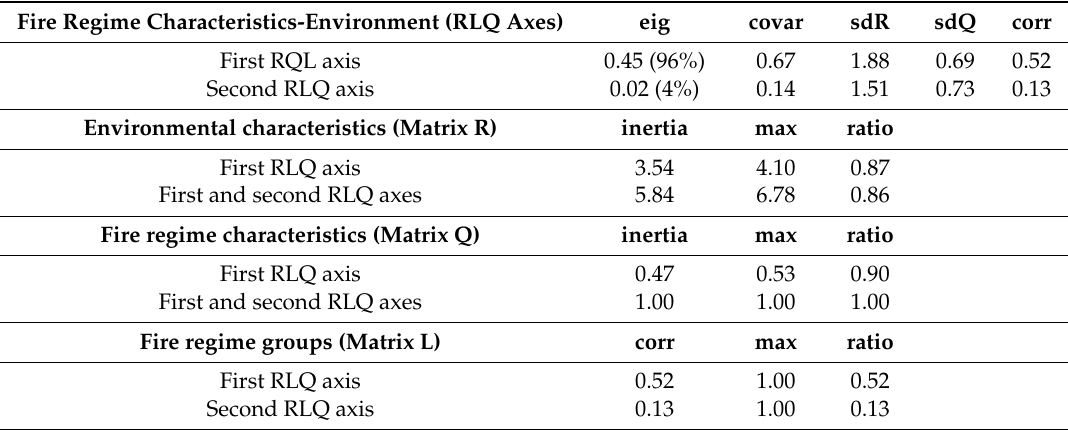
Table 3. Eigenvalue decomposition summary of the RLQ analysis